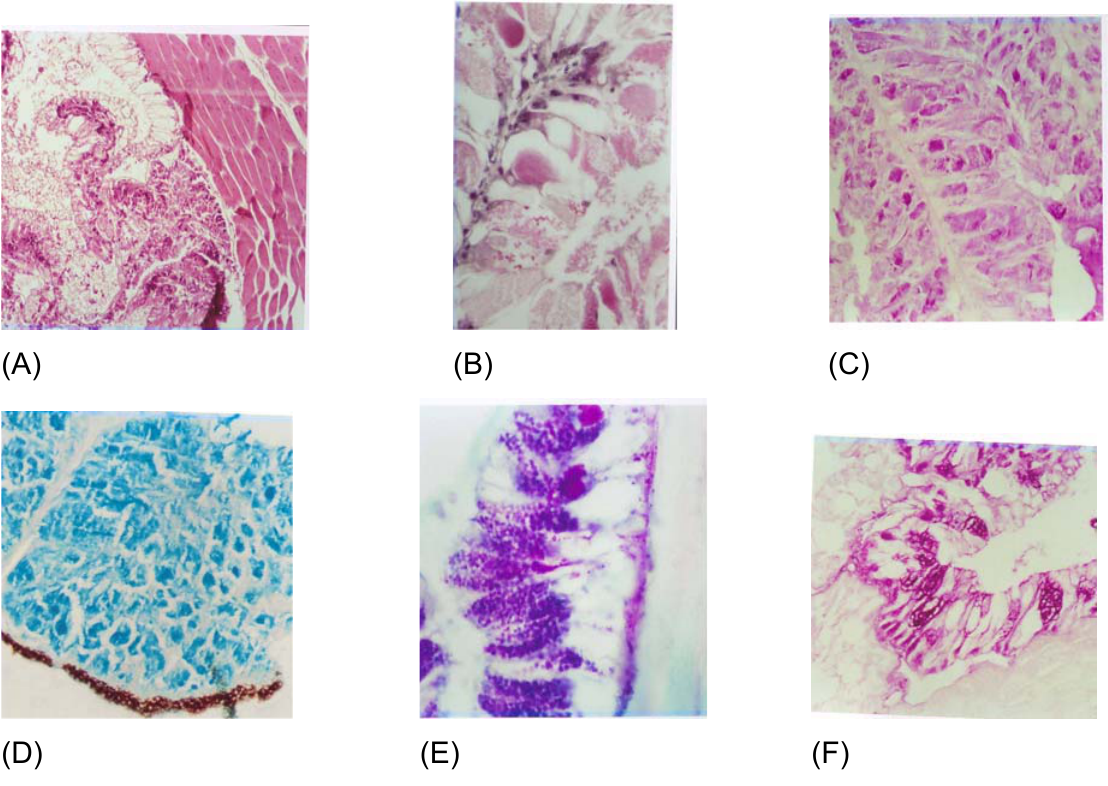
Figure 1. Cross-section of A. crassicauda venom glands stained with: ( A ) hematoxylin-eosin, secretory epithelium covered by striated muscle; ( B ) hematoxylin- eosin, with venom-producing cells and non-secretory supporting cells; ( C ) periodic acid-Schiff stain; ( D ) alcian blue (pH 2.5) stain; ( E ) periodic acid-Schiff-alcian blue (pH 2.5) stain; ( F ) toluidine blue (pH